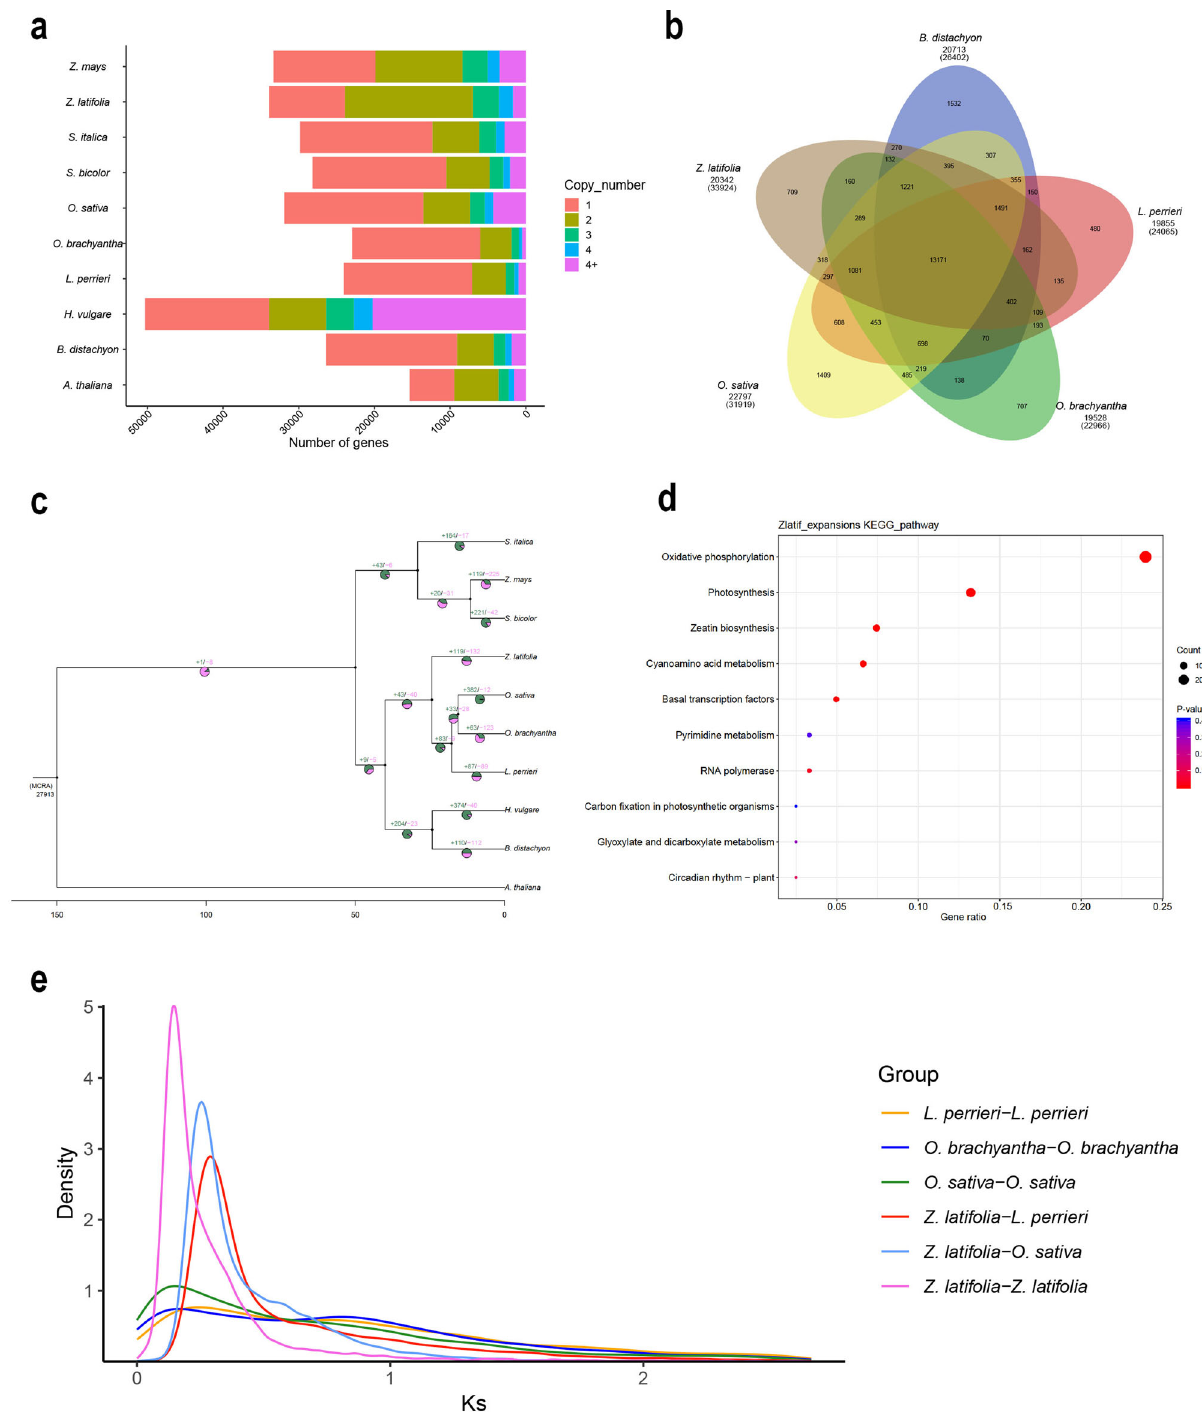
Fig. 3 Comparative genomic analyses of Chinese wild rice genome. a Distribution of gene copy number in Chinese wild rice and nine other species. b Venn diagram of shared orthologous gene families in Chinese wild rice and other four related gramineous species ( Brachypodium distachyon , Leersia perrieri , Oryza brachyantha , and O. sativa ). c Phylogenetic tree of Chinese wild rice and nine other species. “ + ” represents the number of gene families expanded on the node and “ - ” represents the number of gene families contracted on the node. The pie chart shows the proportion of the corresponding branch contraction and expansion gene families. d , KEGG enrichment analyses for the expanded genes in the Chinese wild rice genome. e Ks distribution in Chinese wild rice and other representative